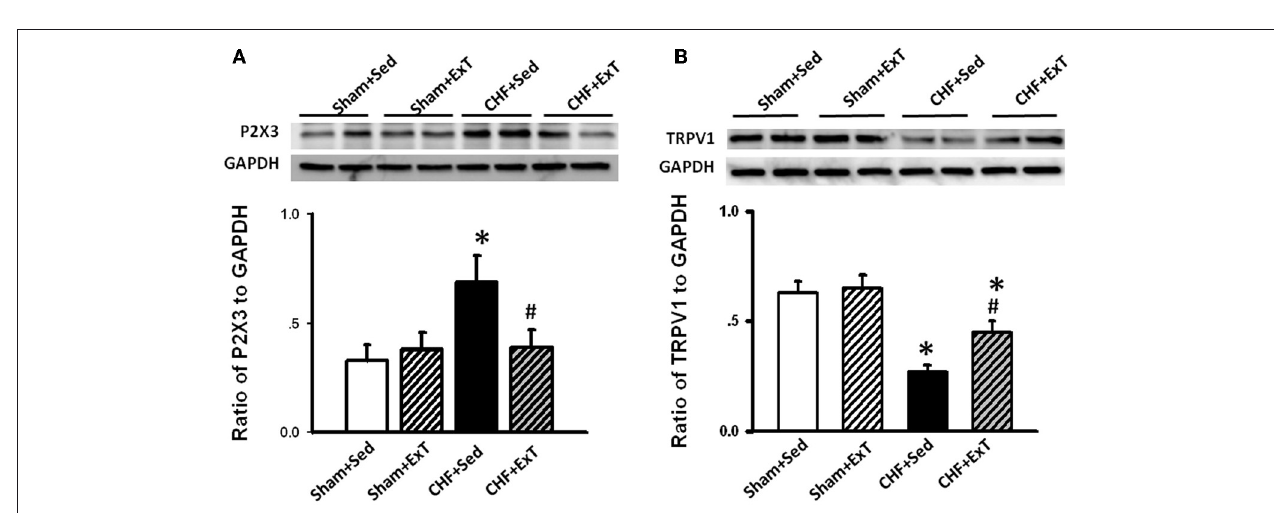
FIGURE 10 | Western blot data showing the protein expression of P2X3 (A) and TRPV1 (B) receptors in L4/L5 dorsal root ganglion (DRG) in Sham + Sed, Sham + ExT, CHF + Sed, and CHF + ExT rats. Data are